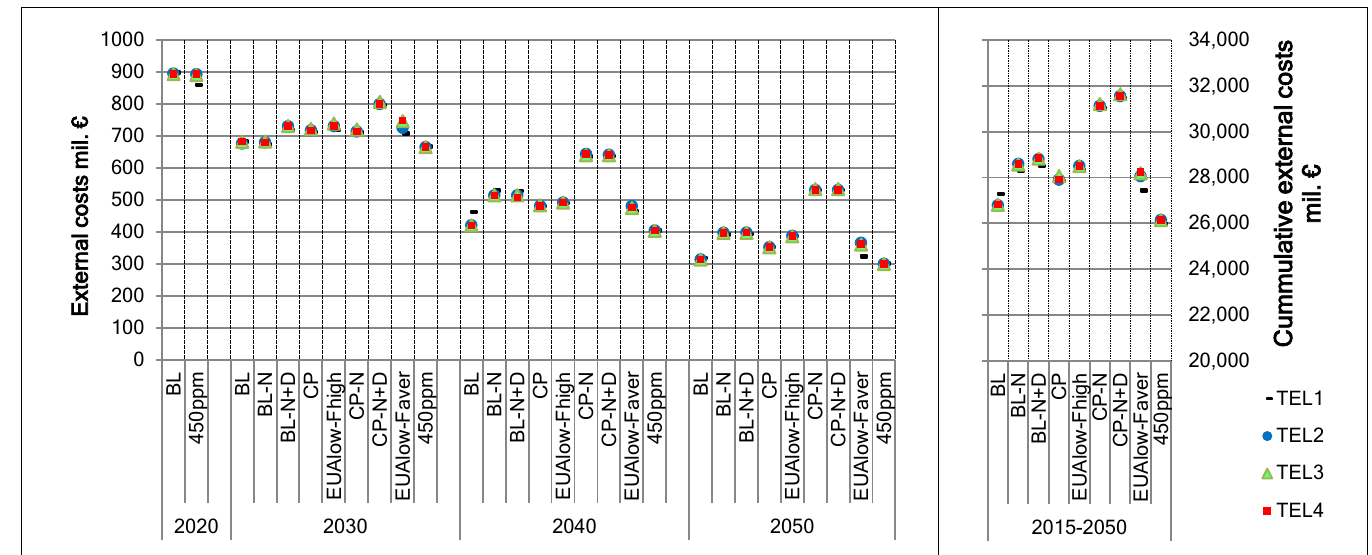
Figure 10. External costs attributable to air quality pollutants released from district heat and power generation, annual averages ( left panel ) and cumulative aggregate over 2015–2050 ( right panel ), in million euro. Note: For sake of clarity, assumption sets BL and 450 ppm in 2020 are displayed only, as the value in other assumption set is on the same level as in